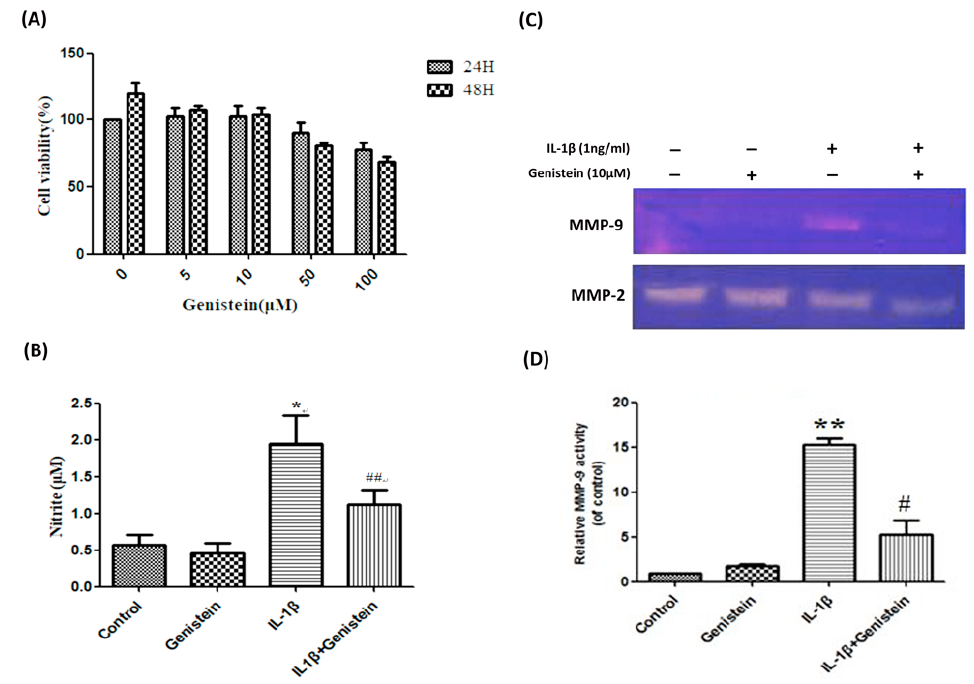
Figure 1. Genistein suppressed IL-1 β -induced NO production and enzyme activity while preventing the IL-1 β -mediated induction of MMP-9. ( A ) The cytotoxicity of genistein on human chondrocytes was evaluated using MTT assays. For this, chondrocytes were incubated with genistein at various concentrations (0, 5, 10, 50, and 100 µ M / mL) for periods of 24 or 48 h. ( B ) Human chondrocytes were stimulated using IL-1 β for 24 h prior to treatment with genistein. The production of NO was determined using the Griess reaction. ( C ) The release of MMP-2 and MMP-9 into cell culture supernatants was assessed using gelatin zymography. ( D ) MMP-9 activity was quantified using Alpha EaseFC software. Results are presented as mean ± SD (Obtained from at least three independent experiments). Significance was determined using a t -test. Significant di ff erences between the genistein group and the control group are indicated by an asterix (*); significant di ff erences between the genistein group and the IL-1 β group are indicated by a pound symbol (#). *, # p < 0.05; **, ## p < 0.01.